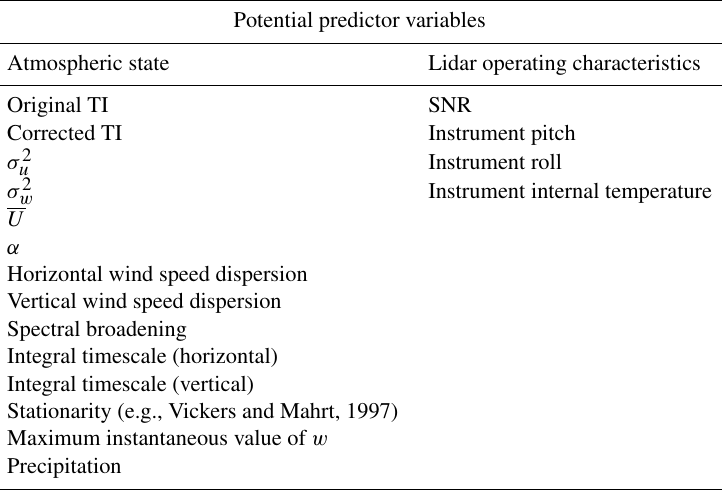
Figure 2. Inset: Google Earth image of the state of Oklahoma. Location of Southern Great Plains ARM site is denoted by white marker. Larger figure: Google Earth image of the central facility of the Southern Great Plains ARM site (outlined in red box) with overlaid elevation contours in feet. Elevation map is from the United States Geological Survey and uses contour intervals of approximately 10 feet (3.05m). Locations of WC lidar and 60m tower are indicated by white markers. Table 1. Potential predictor variables evaluated in the machine-learning module of